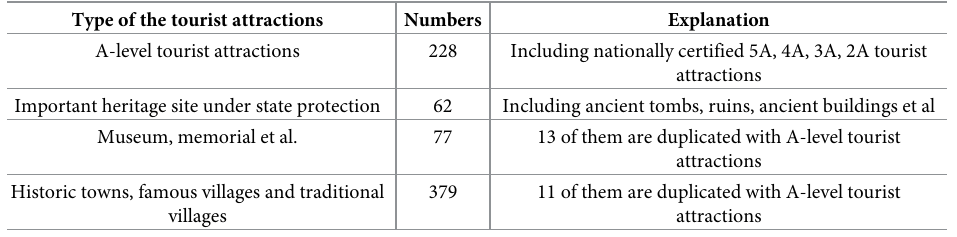
Table 1. Data screening and classification of tourist attractions in demonstration region.